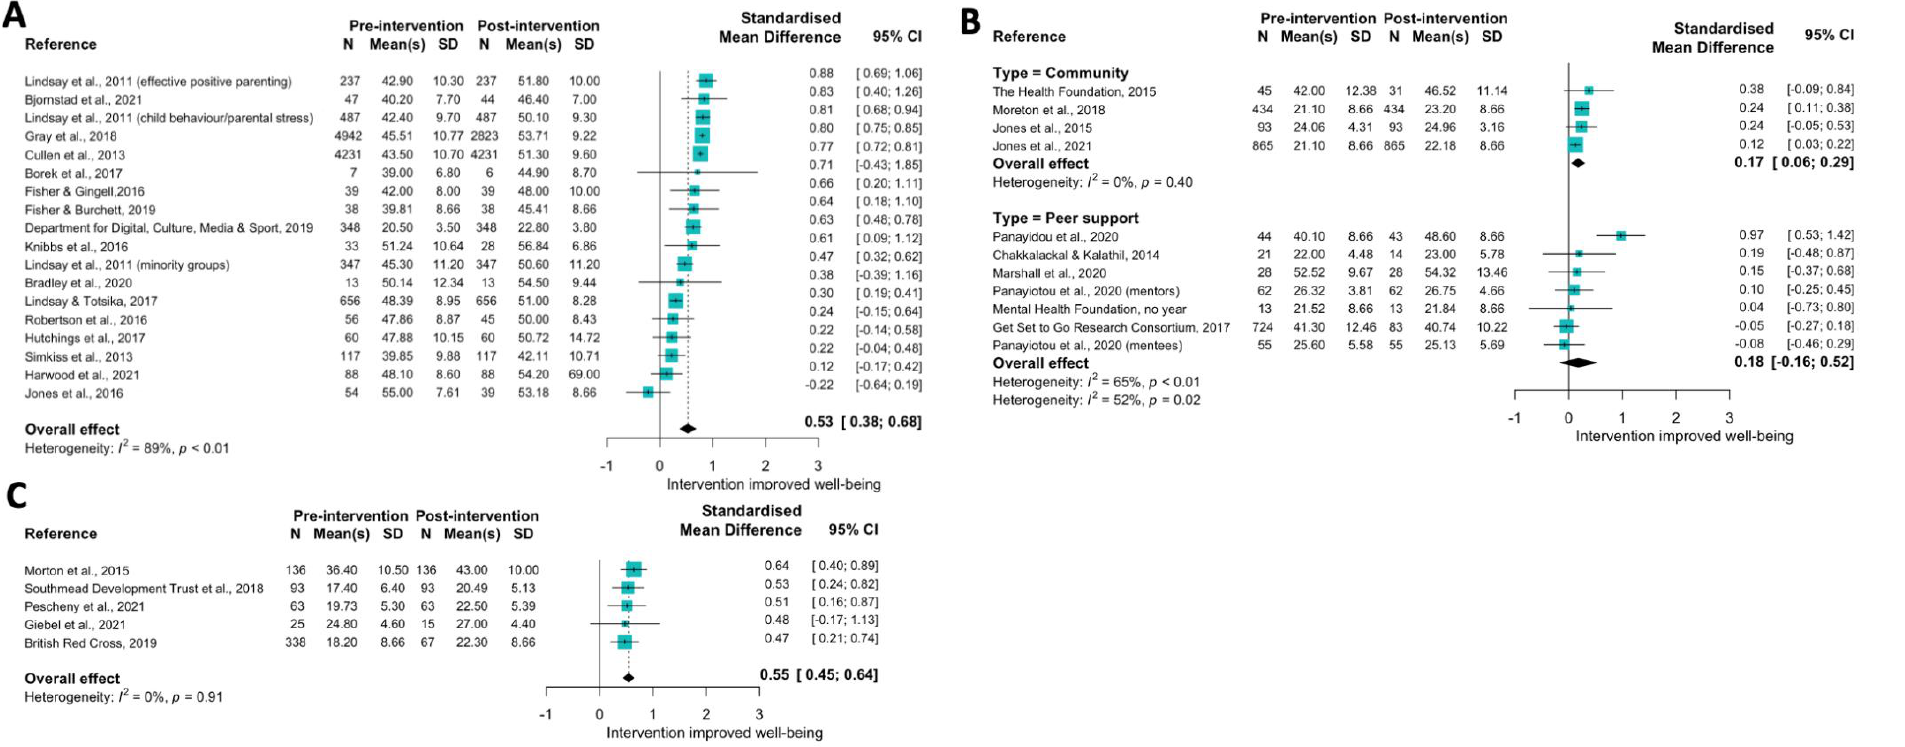
Figure 4. Forest plot indicating change in WEMWBS score (standardised mean difference) from pre to post intervention for the Social theme for ( A ). Parenting; ( B ). Community and Peer support; and ( C ). Social Prescribing interventions [119 – 134,138 – 146,148,151 – 155].